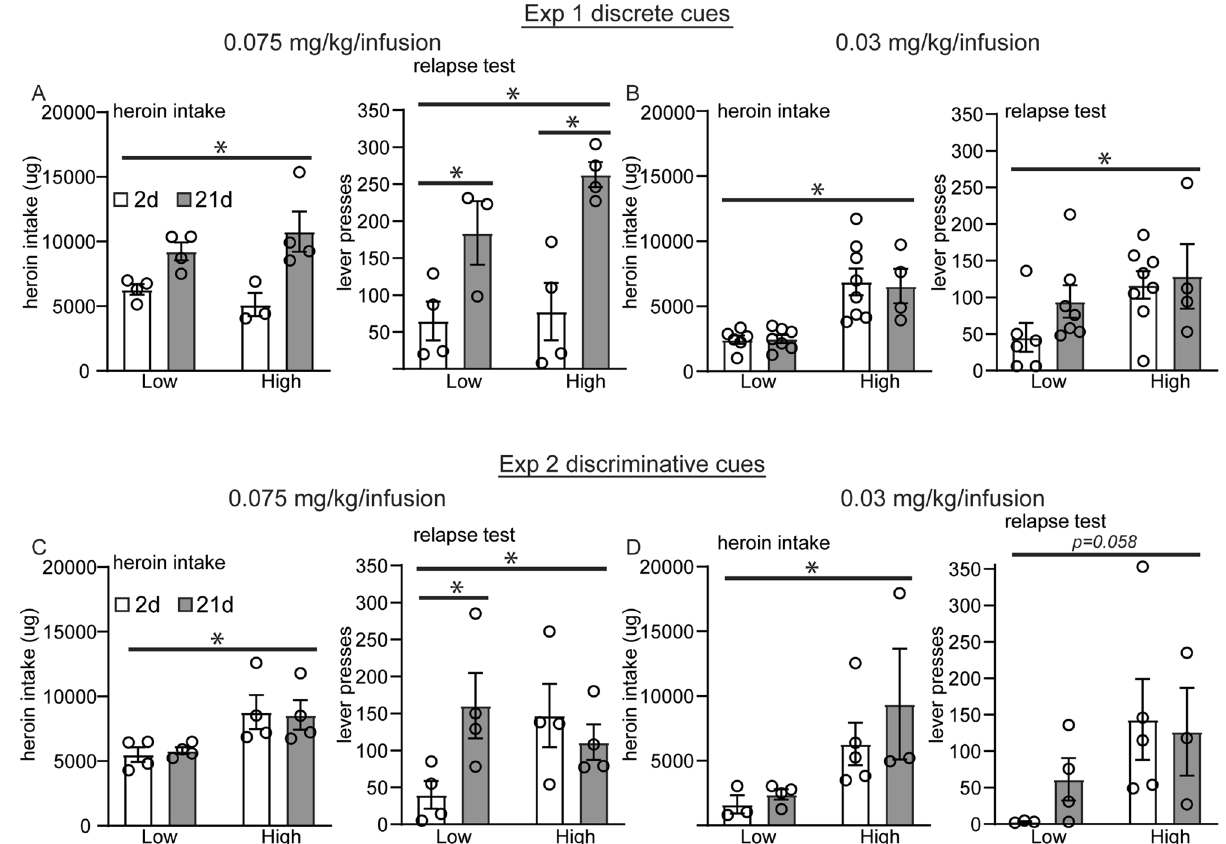
Figure 5. Variability in total drug intake contributes to incubation of craving for discriminative but not discrete drug cues at a 0.075 mg/kg/infusion dose. In each experimental protocol, some animals self-administered high total heroin intake or lower amounts of total heroin intake. Animals were classified as high or low heroin takers based on whether they were above or below the median total heroin intake for their experimental protocol. Shown are the average amounts of total heroin intake over 10 days of heroin self-administration as well as active lever pressing during a 90 min relapse test at 2 or 21 days after the last drug session for experiment 1 with discrete drug cues ( A , B ) and experiment 2 with discriminative drug cues ( C , D ). Error ± SEM. * p <